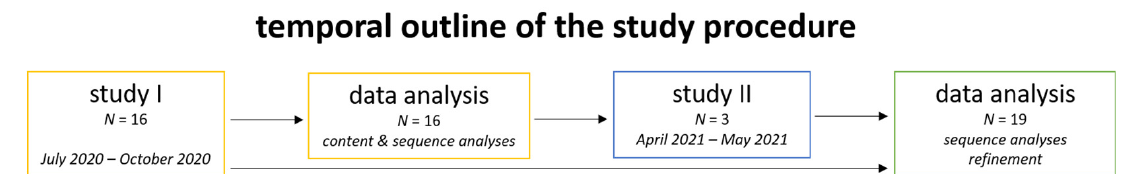
Figure 2. Temporal outline of the study procedure.